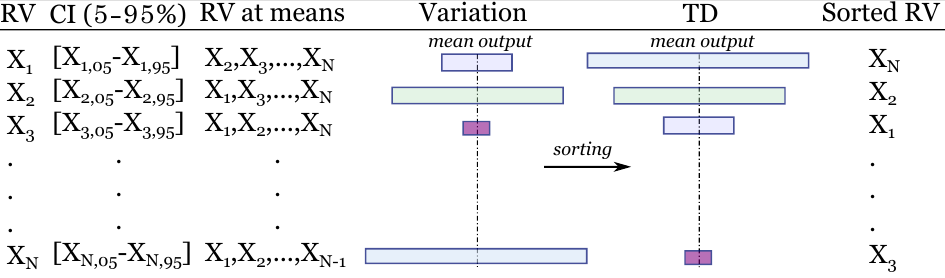
Figure 2. Tornado diagram (TD)